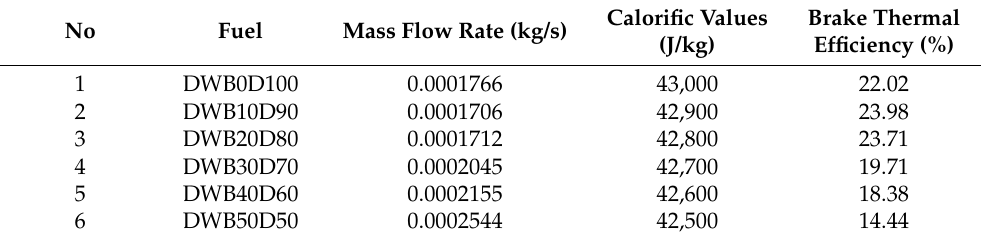
Table 7. Brake thermal efficiency of engine using blends of distilled WCO-biodiesel and mineral